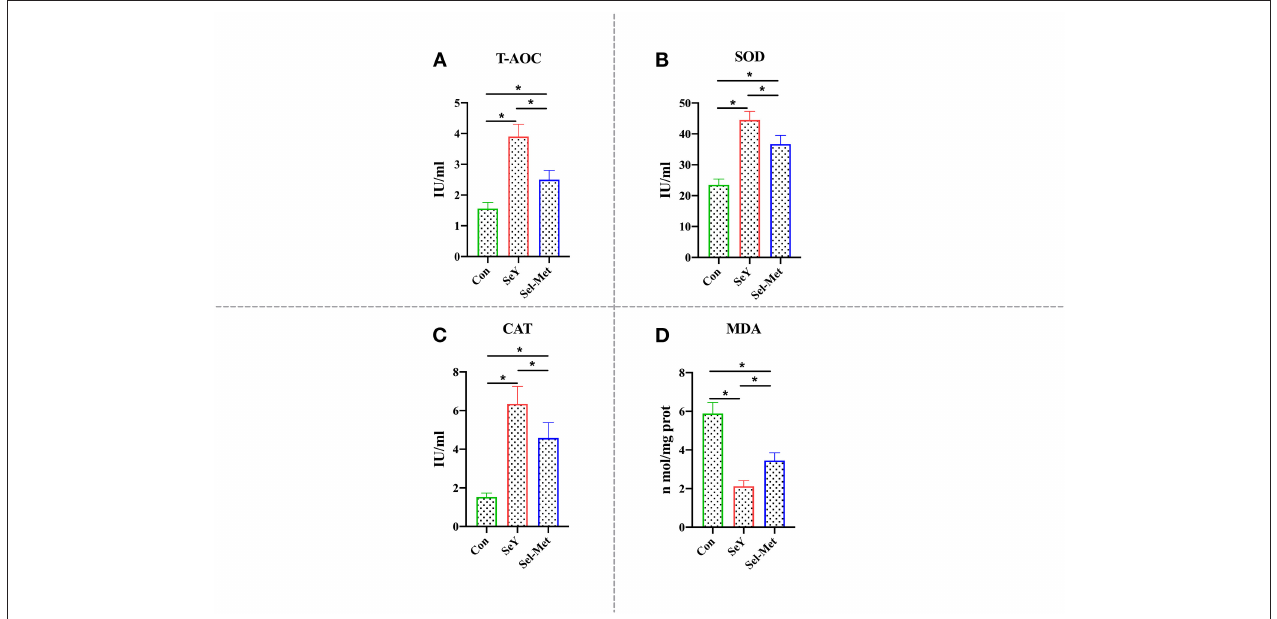
FIGURE 6 | Effects of SeY and Sel-Met supplementation on (A) T-AOC, (B) SOD, (C) CAT, and (D) MAD in PMECs. Cells were incubated for 24h with 0.6 ppm SeY and Sel-Met, and then were collected for T-AOC, SOD, CAT, and MAD activity analysis. Data are expressed as mean ± SEM ( n = 6). *Indicates that the difference was statistically significant ( P <